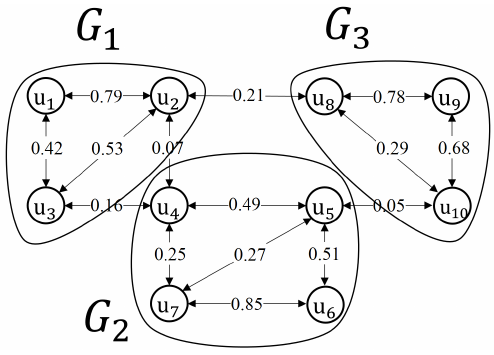
Figure 2. The social groups.